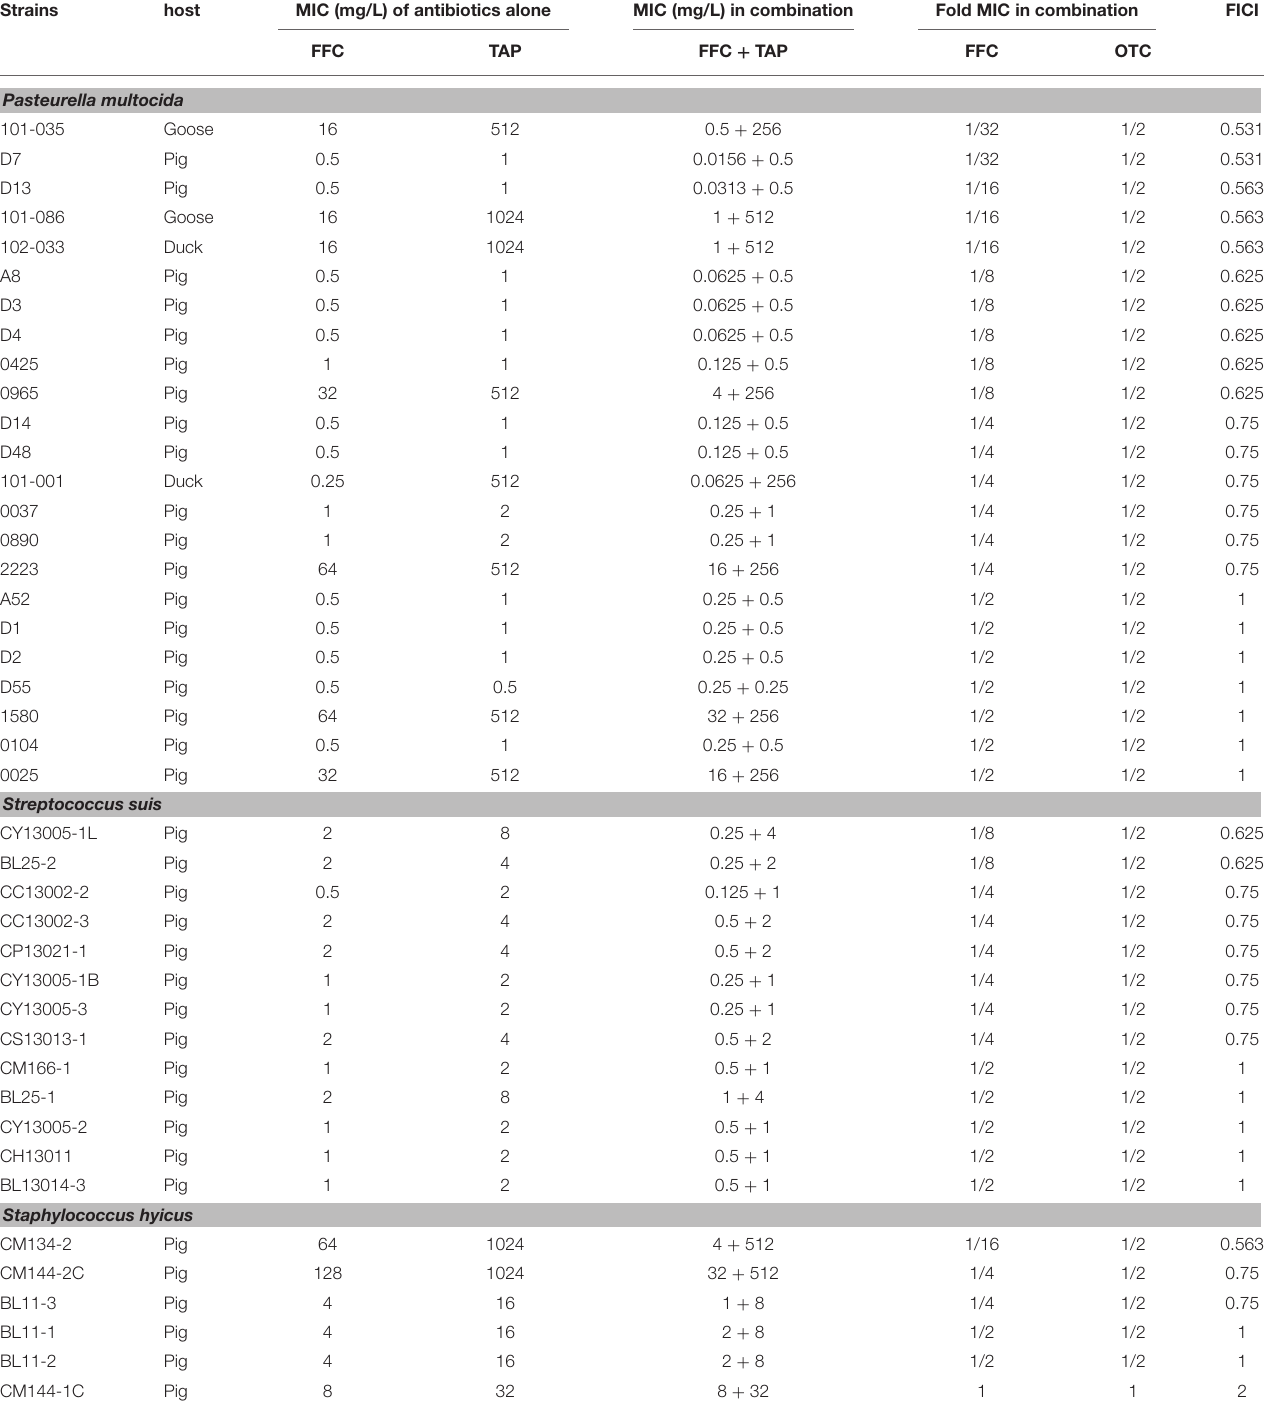
TABLE 1 | In vitro inhibitory activity of florfenicol (FFC) and thiamphenicol (TAP) alone and in combination against P. multocida , S. suis , and S. hyicus .